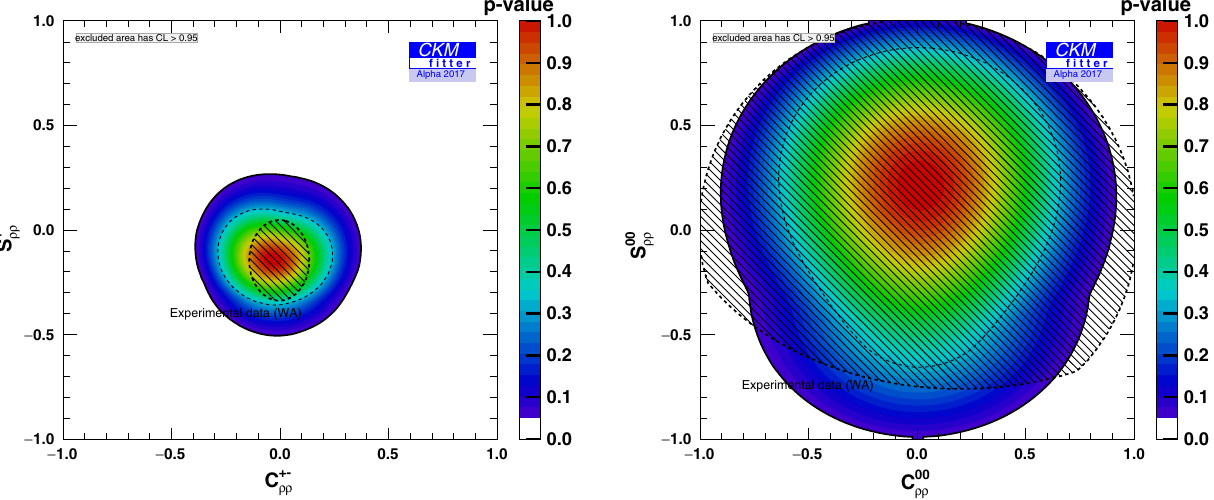
Fig. 30 Two-dimensional constraint on the B 0 → (ρρ) 0 CP asymmetries in the ( C , S ) plane. The direct measurement, not included in the fit, is indicated for each mode as a shaded